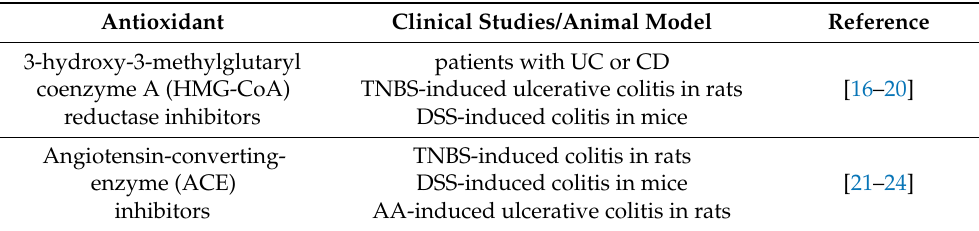
Table 1. Synthetic antioxidants used in IBD